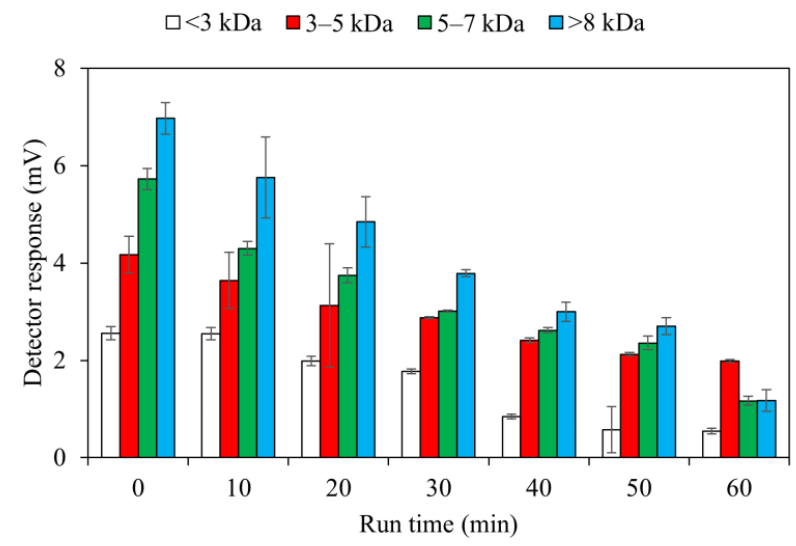
Figure 7. The changes of molecular size of DOM during RF treatment ( n = 8).